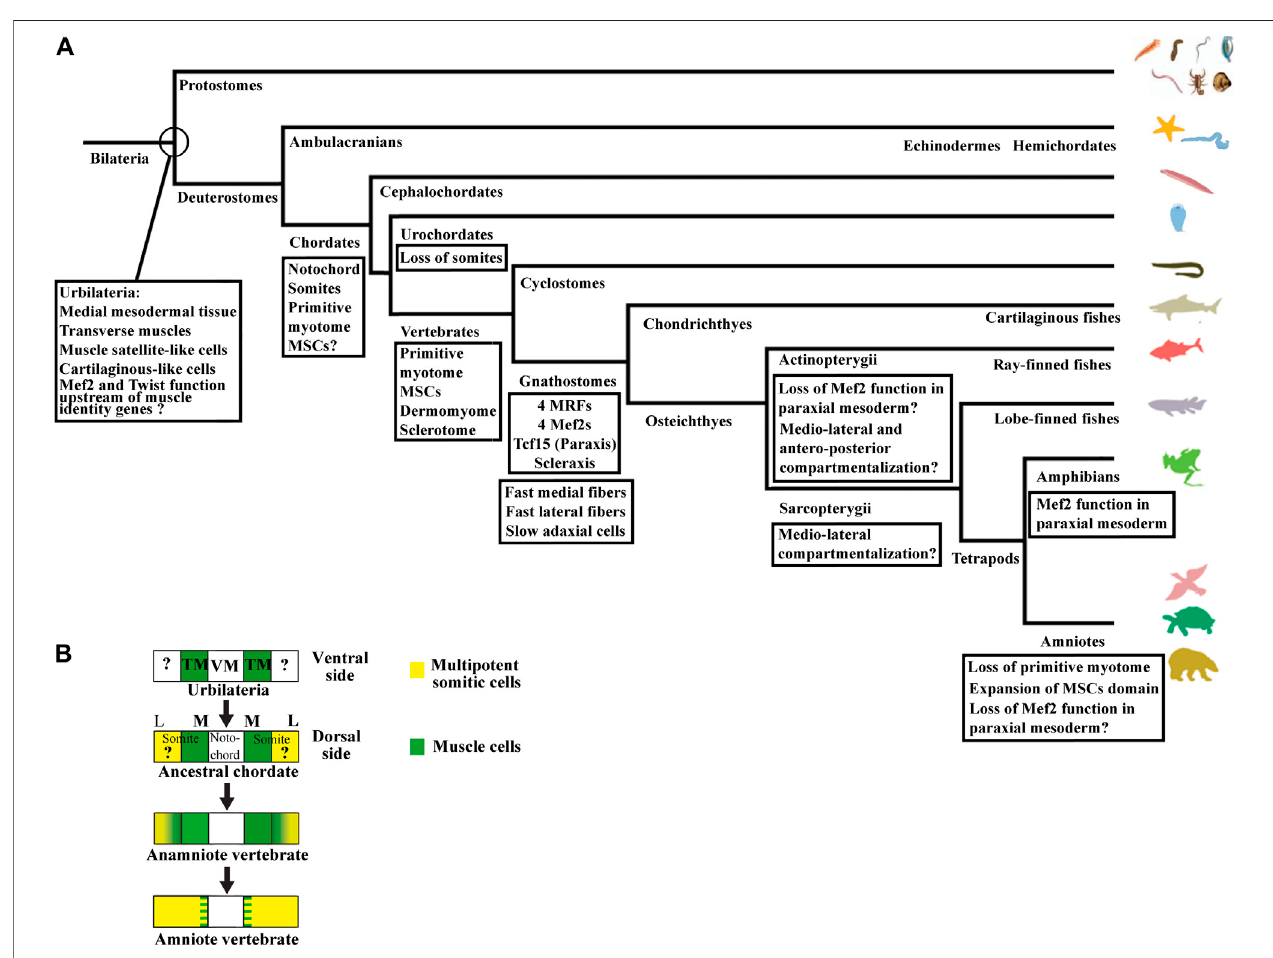
FIGURE 8 | (A) Summary of the main changes during the evolutionary history of somites compartmentalization. The last common ancestor of bilaterians, Urbilateria, possesses neither somites nor notochord, but probably transverse muscles and a medial mesodermal tissue according to the axochord hypothesis (Brunnet al, 2015; Yasuoka, 2020). Satellite-like cells and cartilage-like cells are also probably already present in Urbilateria. Regarding the transcription factors expressed invertebratesomites,resultsfrom Drosophila and Xenopus suggestthat Mef2 andTwist could actupstreamofmuscleidentitygenesinUrbilateria. The notochord and the somites appear in chordates. The somite is made up of the primitive myotome and probably multipotent progenitors which give rise to satellite cells and muscle-associated tissues ventrally and dorsally. The existence of sclerotome-like cells in cephalochordates suggests that the somitic progenitors can already give rise to specialized connective tissue cells. In vertebrate, the somites compartmentalize mainly into the myotome, the dermomyotome, and the sclerotome. In gnathostome vertebrates, the three populations of slow, lateral fast, and medial fast muscle fi bers has been characterized. The genome possesses both Scleraxis and Tcf15genes,butalsofourMRFsandfourMef2genes.Thenon-conservation ofMef2functionintheparaxialmesoderm andthechangesincompartmentalizationmode between zebra fi sh and Xenopus raisethe question ofthe origin ofthese variations. (B) Evolution ofsomite compartmentalization based on axochordhypothesis(Brunet et al., 2015; Yasuoka, 2020). The axochord hypothesis (the axochord in annelids and the notochord in chordate are homologs) proposes that the notochord evolves fromamedialmesodermaltissuepresentinUrbilateria,thelastcommonancestorofallbilaterians,andsuggeststhattransversemusclesattachedtoit,couldgiveriseto the primitive myotome in ancestral chordates. The origin of MSCs in Urbilateria is unknown. Proto-MSCs probably already exist in last chordate ancestor. The transition from ancestral chordates to vertebrates allowed MSCs to give rise to all new somite structures, i.e., the dermomyotome, its hypaxial region, and the sclerotome. The transition from anamniote to amniote vertebrates is characterized by expansion of the MSCs domain at the expense of the primitive myotome. The chordate dorso- ventral axis is inverted compared with Urbilateria. Anamniote vertebrate is used in Figure 8B as the somite organization of the extant anamniote vertebrates are considered to be closed to the primitive one. VM, ventro-medial mesodermal tissue; TM, transverse muscle; M, medial somite region; L, lateral somite region.